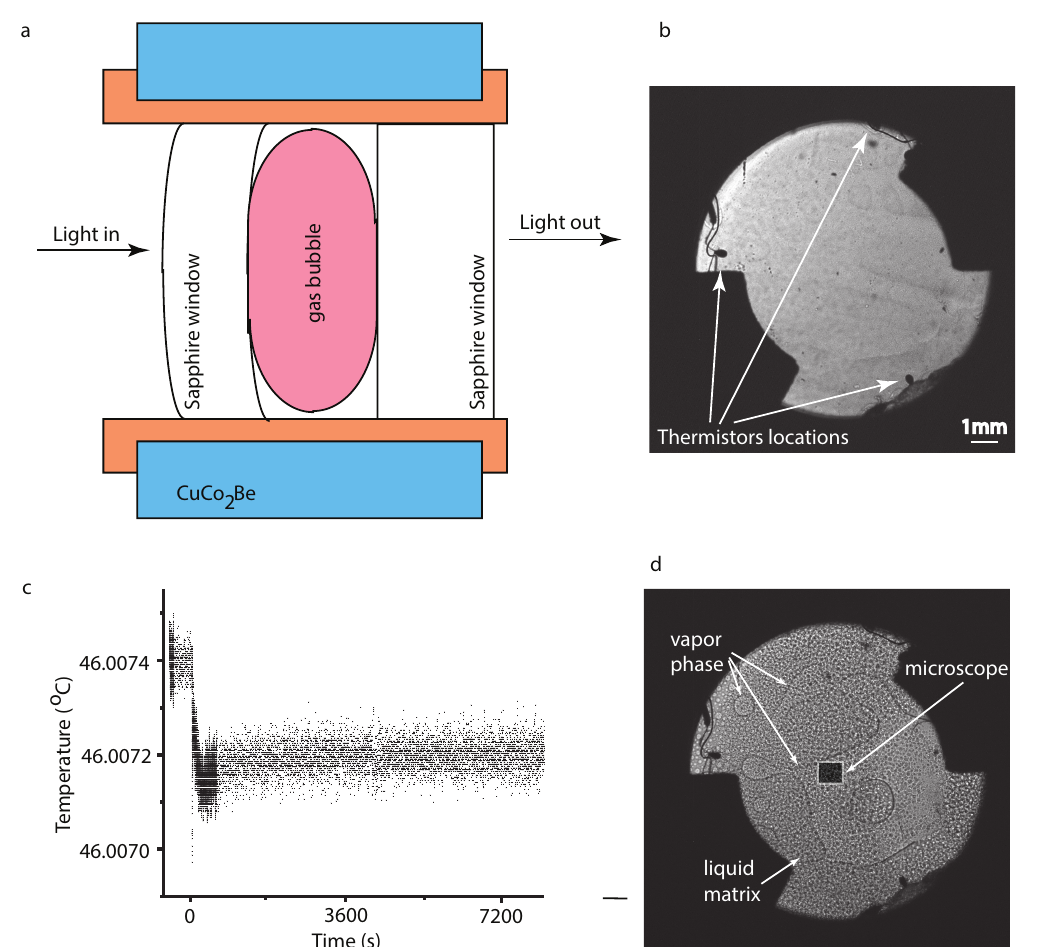
Figure 1. ( a ) a schematic cross section (not to scale) of the Direct Observation Cell (DOC) dedicated to studying sulfur hexafluoride (SF 6 ) phase separation in Dispositif pour l’Étude de la Croissance et des Liquides Critiques (DECLIC) with Alice Like Instrumentation (ALI). experiments; ( b ) a wide field of view (WFOV) image of the DOC at equilibrium in the two-phase range recorded 100 s prior to the application of 0.2 mK temperature quench; ( c ) the DOC was slightly below the critical temperature when the cooling down temperature quench of 0.2 mK was applied at t = 0 s; ( d ) as a result of the 0.2 mK thermal quench, a double phase separation takes place with liquid droplets nucleating inside the vapor phase and vapor bubbles forming inside the liquid matrix. A microscope magnifies a 1 mm × 1 mm square area at the center of the